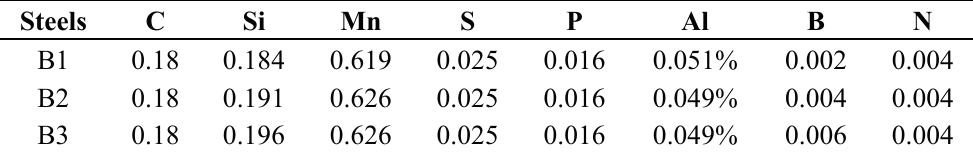
Table 4. Chemical composition of the test steels (mass percent,